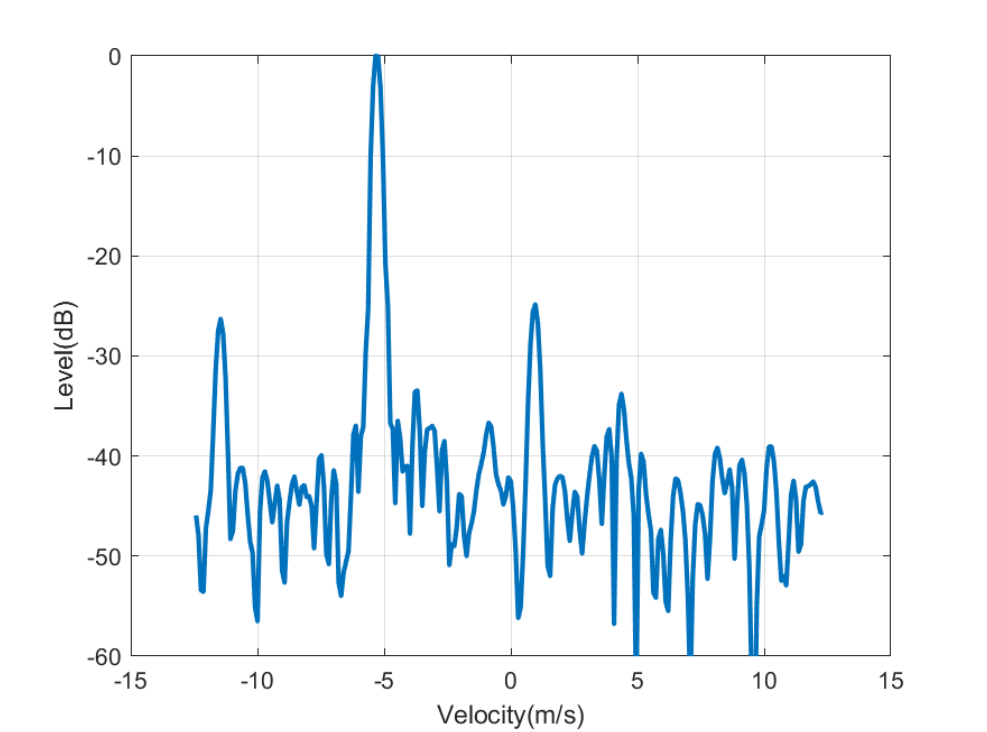
Figure 16. Cut of the range—Doppler map of Figure 14 as a function of the velocity for the range where is detected the transponder modulated at 1000